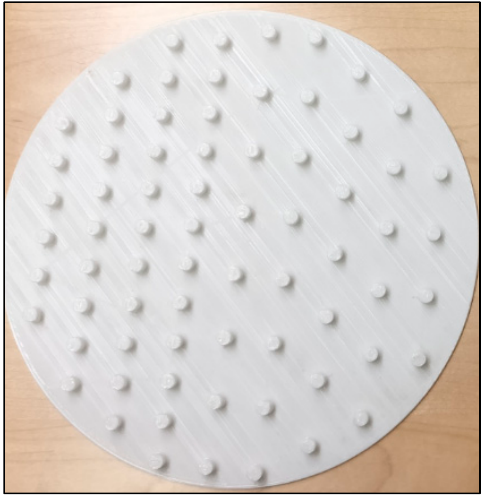
Figure 7. Dimpled mat 3-D printed with NinjaFlex. The spacing of the dimples can be adjusted to hold various tube sizes.